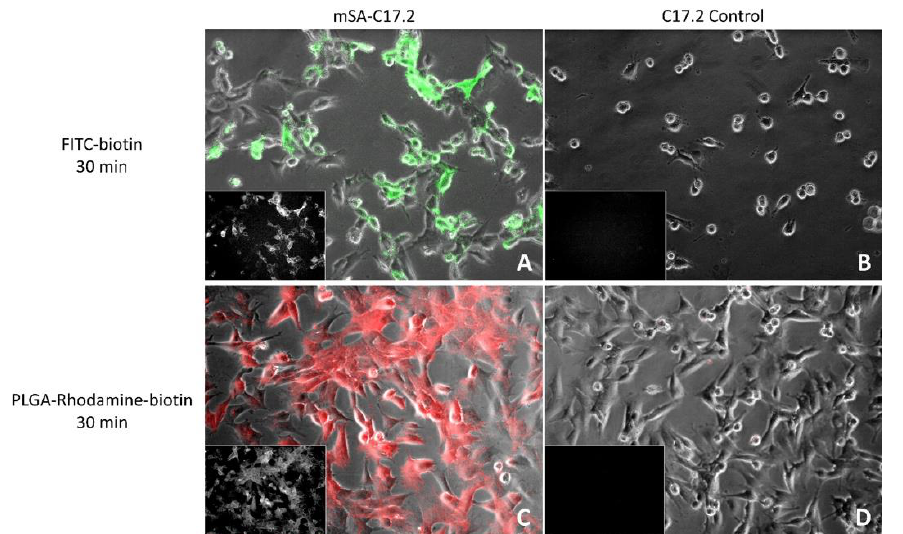
Figure 4. The cmSA protein can bind small molecules or nanoparticles containing biotin. ( A ): cmSA-C17.2 labeled with biotin (5-fluorescein); ( B ): C17.2 labeled with biotin (5-fluorescein); ( C ): cmSA-C17.2 labeled with PLGA-rhodamine-biotin; ( D ): C17.2 labeled with PLGA-rhodamine-biotin. Green = fluorescein fluorescence. Red = rhodamine fluorescence. Insets : A/B: fluorescein fluorescence without bright field overlay. C/D: rhodamine fluorescence without bright field overlay.